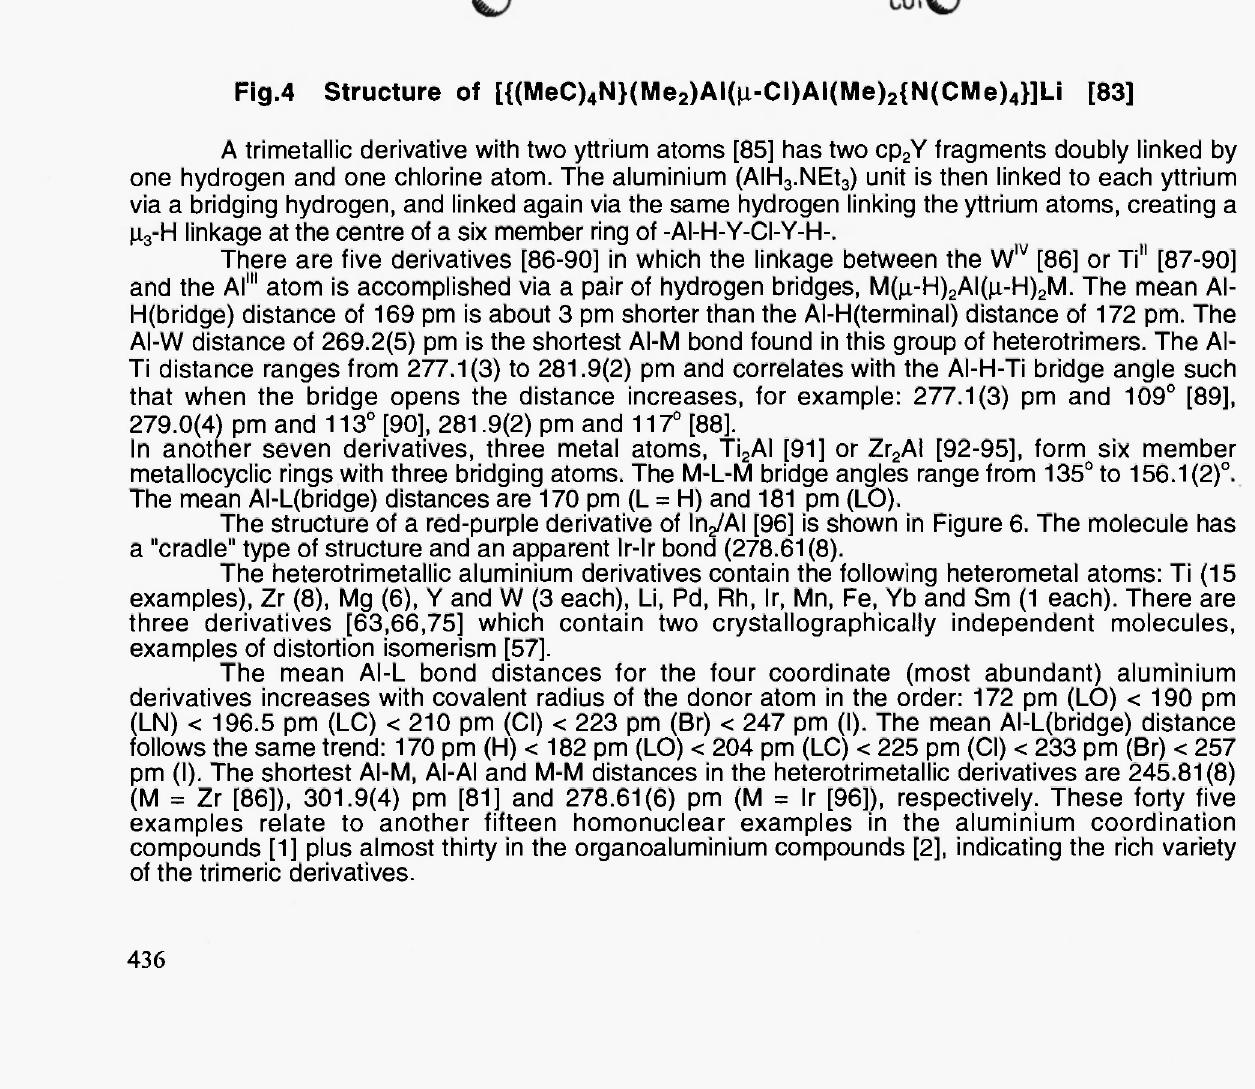
Fig.4 Structure of [{(MeC)